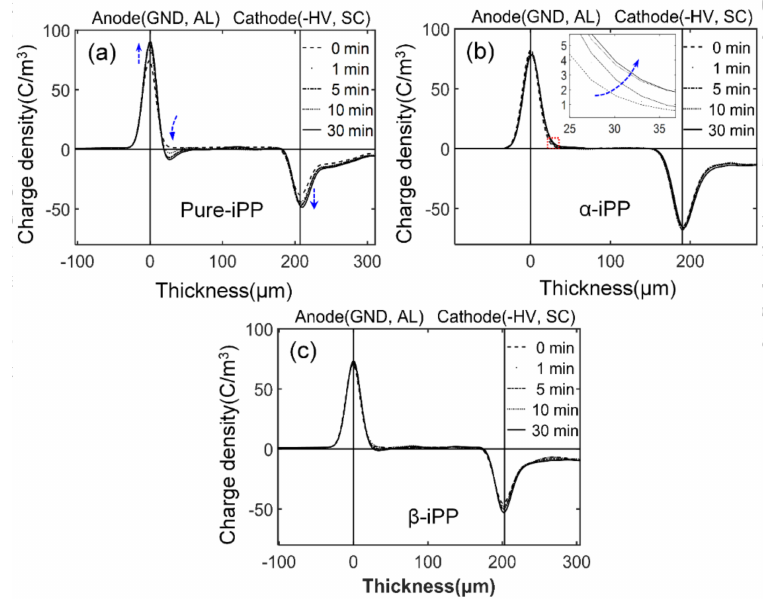
Figure 9. Space charge distribution in iPP samples poled under − 100 kV/mm at room temperature